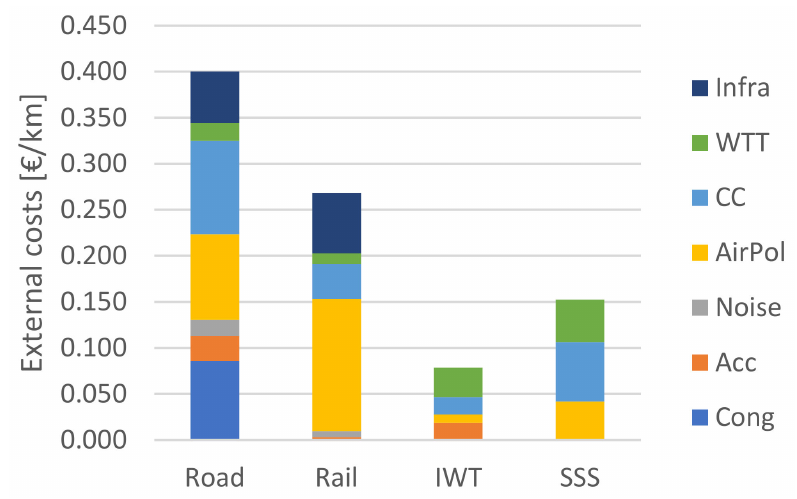
Figure 8. External cost types most prevalent for each mode of transportation.